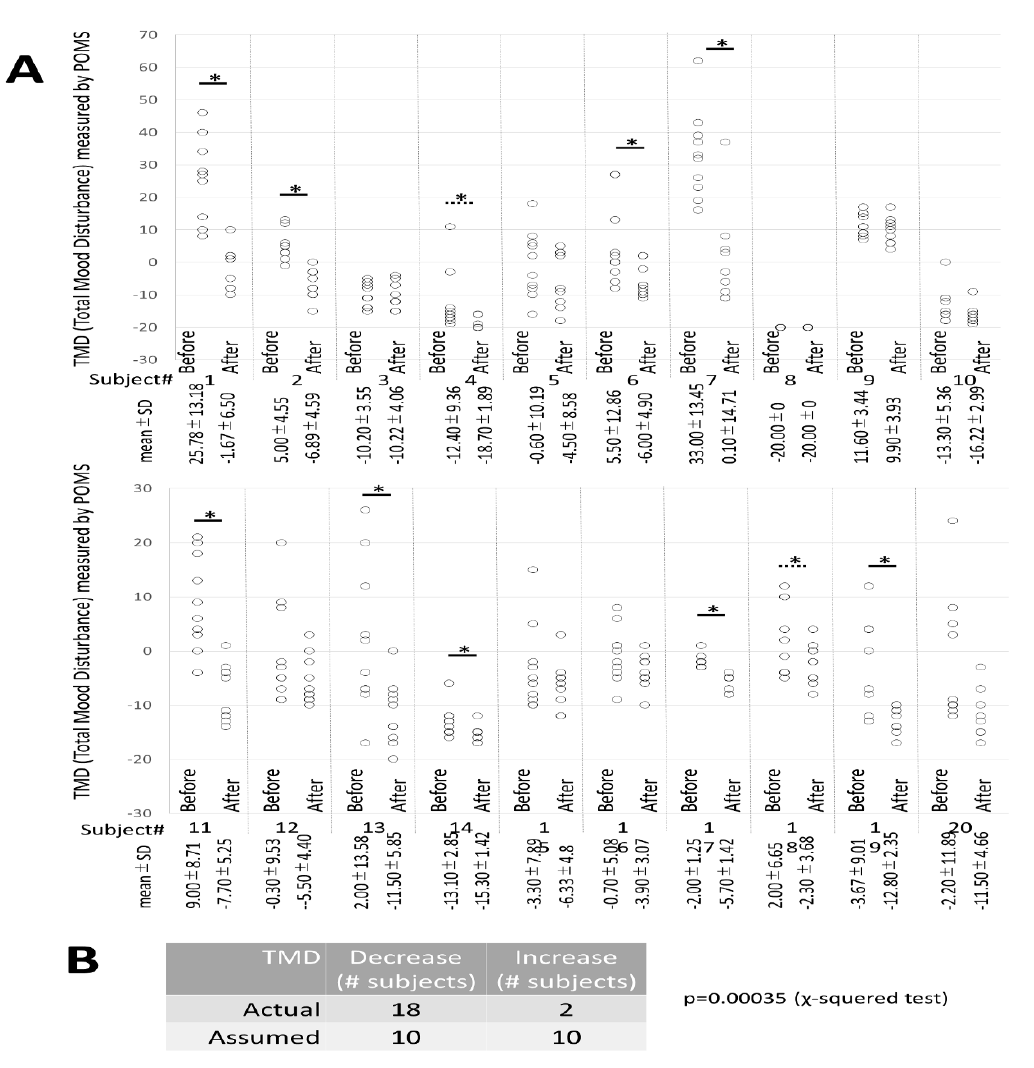
Figure 5. TMD from POMS2 Questionnaire. ( A ) The mean ± standard deviation of TMD before and after 10 lessons of the 20 individual subjects is shown. Eight out of twenty subjects showed significantly lower values after the lesson compared with values before the lesson. Two subjects showed a decreasing tendency (0.1 > p > 0.05). ( B ) A comparison was not made between groups before and after the lesson, but the number of people whose values after and before or after before and after were compared. Assuming that the predicted value would decrease or rise by half, the results indicated a decrease in 18 subjects and a rise in 2 subjects. In the chi-squared test, there were many subjects who dropped significantly ( p = 0.00035).